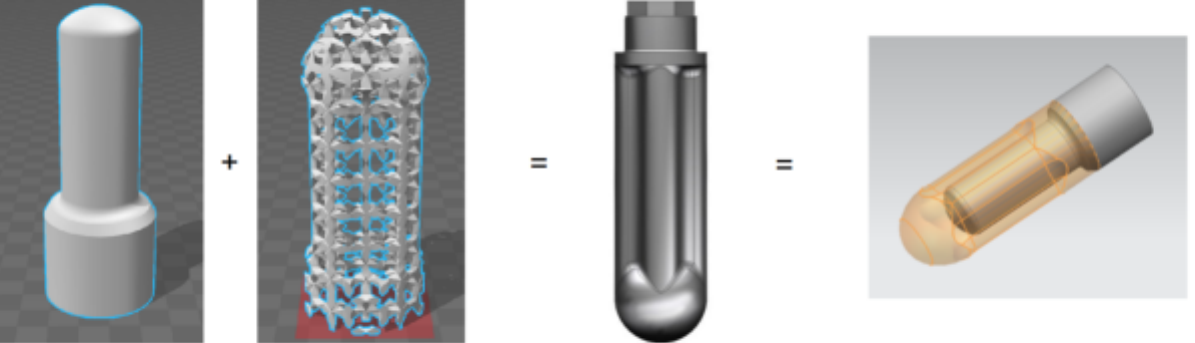
Figure 7. Two STL files showing the final geometrical solution of the implant (trabecular outer shell second from left) (left), the final implant model (middle) and homogenized layer of the outer trabecular structure for easier simulations